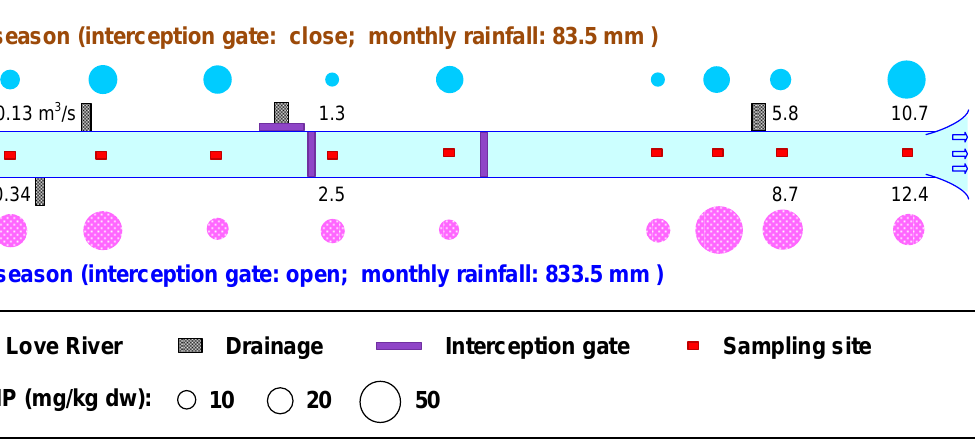
Figure 2. The distribution of DEHP concentrations in the sediments of Love River in the dry season and the wet season.